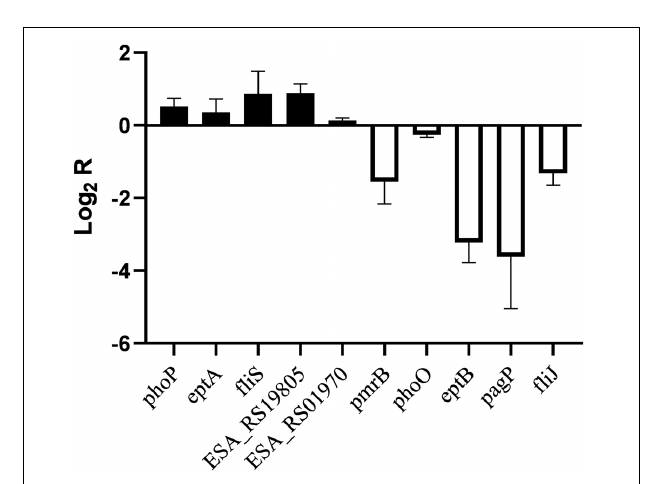
FIGURE 4 | RT-PCR analysis for transcriptional levels of genes related to phenotype in C. sakazakii pmrA in pH 5.0, using C. sakazakii wild strain in